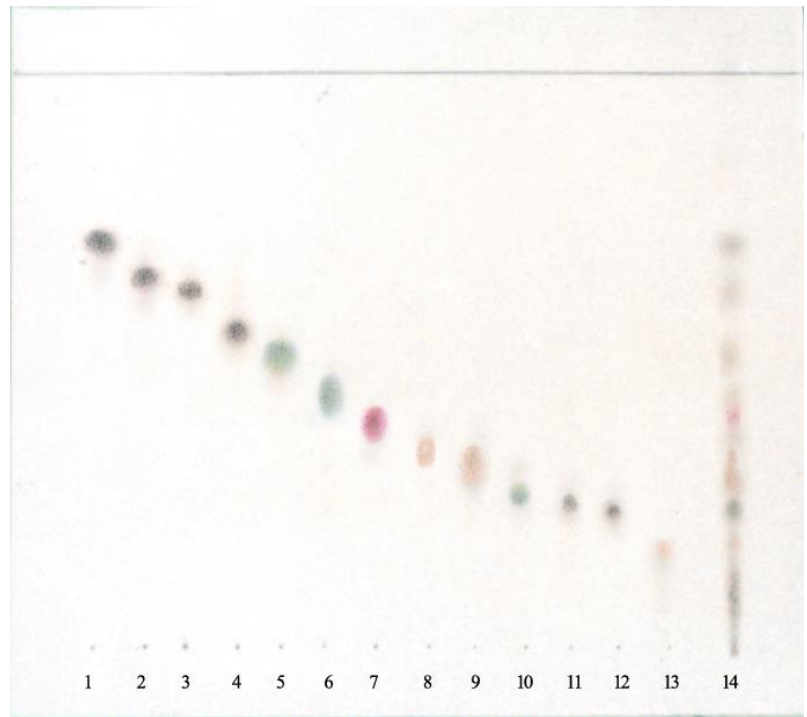
Figure 2. TLC of lipophilic compounds from Psephellus bellus . Adsorbent: silica gel. Mobile phase: